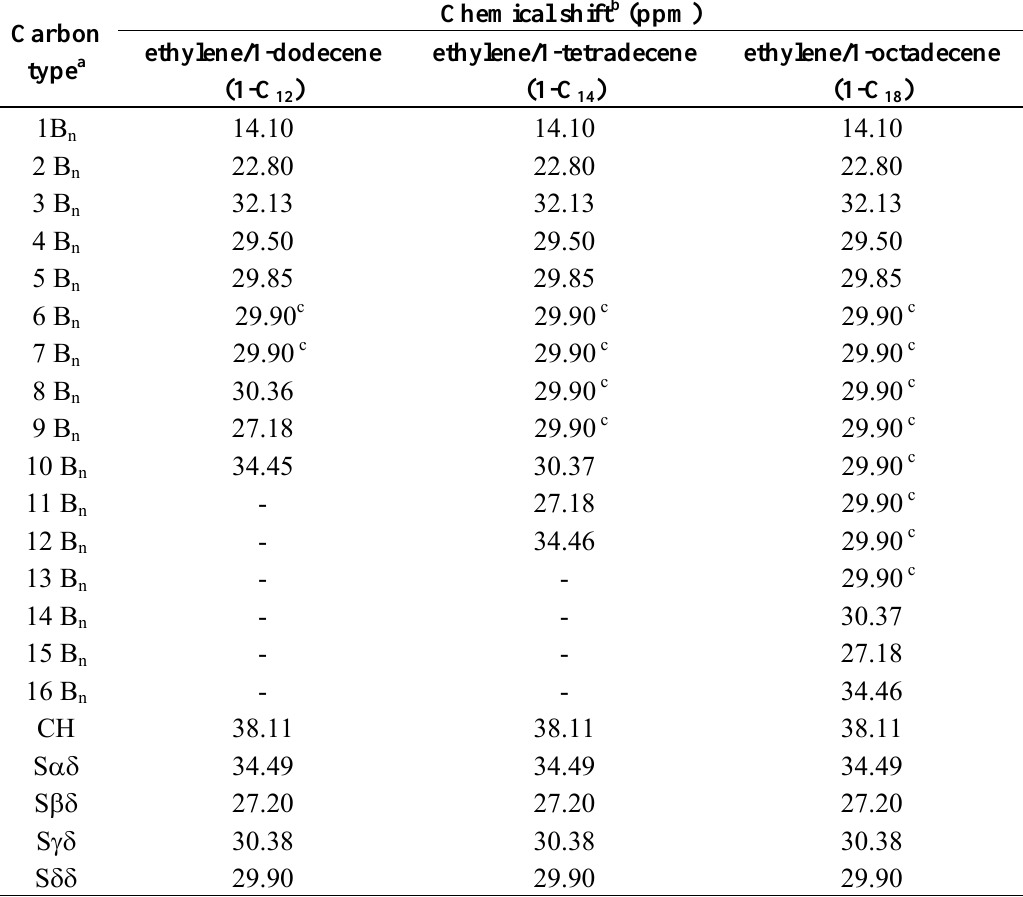
Table 2. Chemical-shift assignment in 13 C-NMR spectra of ethylene/1-dodecene,